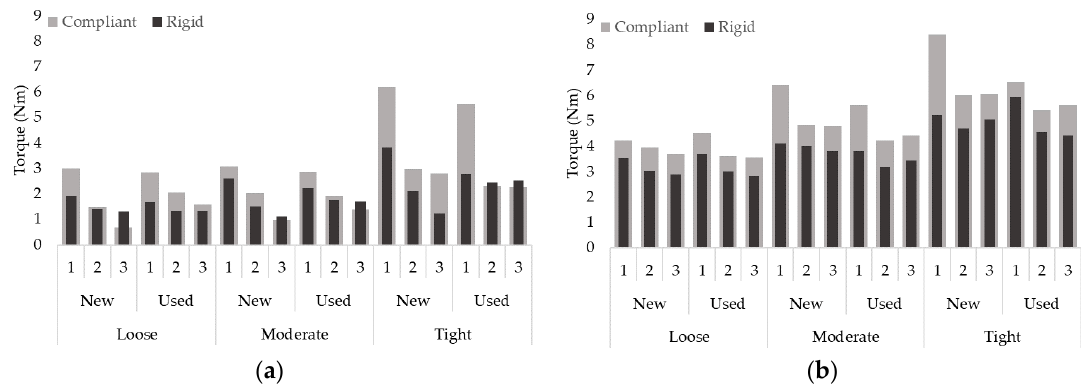
Figure 3. Torque at 75° wrist extension for ( a ) short and ( b ) long protector. The x-axis indicates the test repeat, protector condition, and strapping condition.